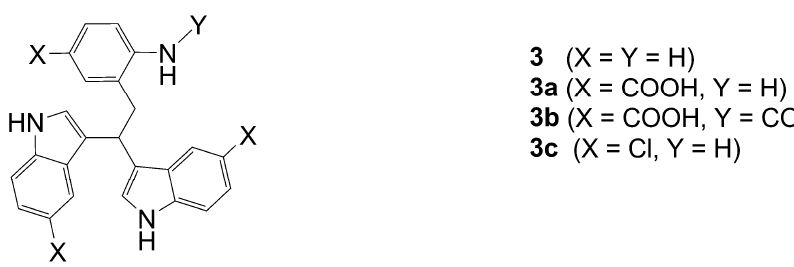
Figure 1. Indole